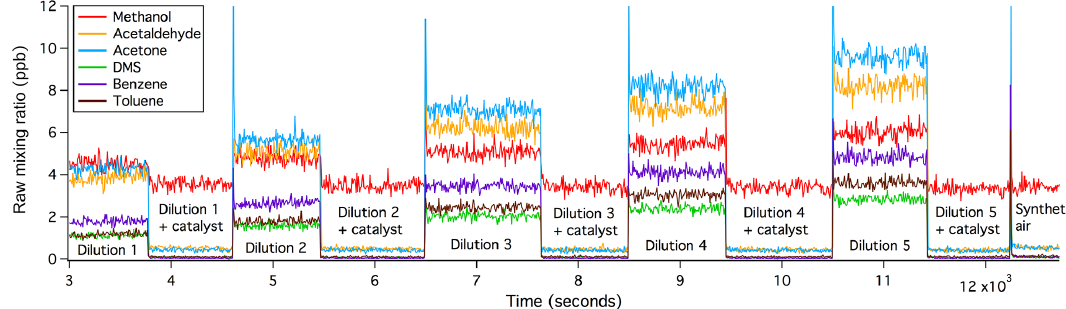
Figure 2. Catalytic oxidations of VOCs were complete, immediate, and independent of the VOC input within the range tested.